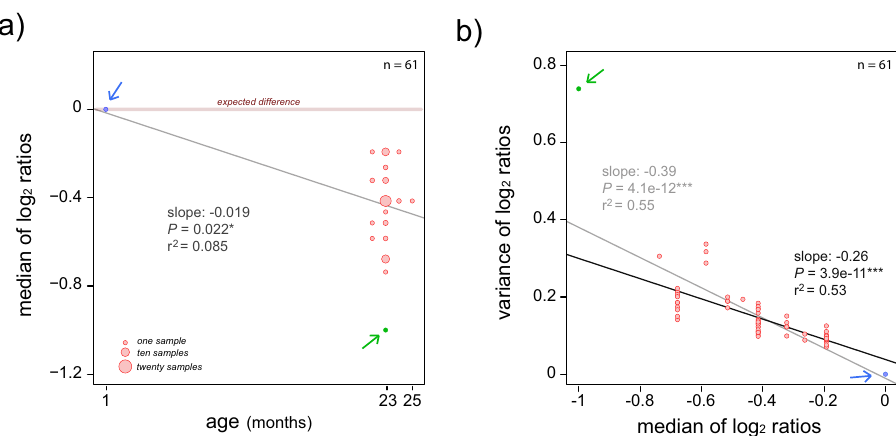
Fig. 4 Log 2 ratios of ChrY coverage compared to the age of the rats. a Dot plot showing the median values of the log 2 ratios of ChrY sequencing coverage in young versus old rats. The blue point at value zero represents the log 2 ratio of ChrY from the young rat against itself. The green dot is the sample from old rats with the greatest coverage difference against ChrY from the young rat (Fig. 3h, fi fth sample). The arrows point at these values. Signi fi cant differences, Linear Model: lm[median.chrY.ratios ~ age]. Exact p values are indicated, * represents P < 0.05. b Dot plot of the median values of the log 2 ratios against its variance. Signi fi cant differences, Linear Model: lm[variance.ratios ~ median.chrY.ratios]. Exact p values are indicated, * represents P < 0.05; *** represents P < 0.001. The results from two linear models are shown: the linear tendency in light grey includes all data points, whereas the linear tendency in black excluded the blue dot (young ChrY) and the green dot (ChrY with the lowest log 2 ratio). The arrows point at these